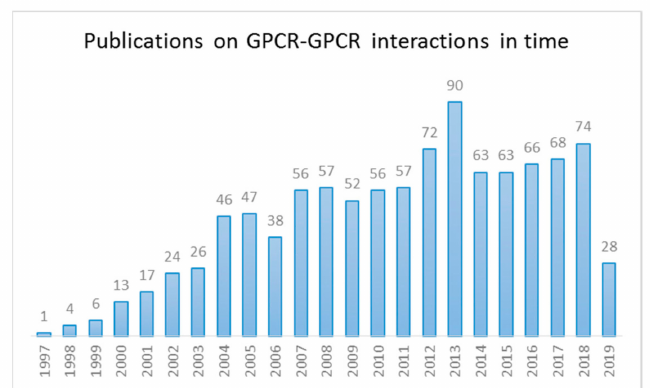
Figure 1. Number of publications on G protein-coupled receptor (GPCR) dimer and oligomers from 1997–2019 (data incomplete for 2019). (Source: NCBI—a search for the terms “GPCR* AND DIMER*’ or ‘GPCR* AND OLIGOMER*” in the PubMed